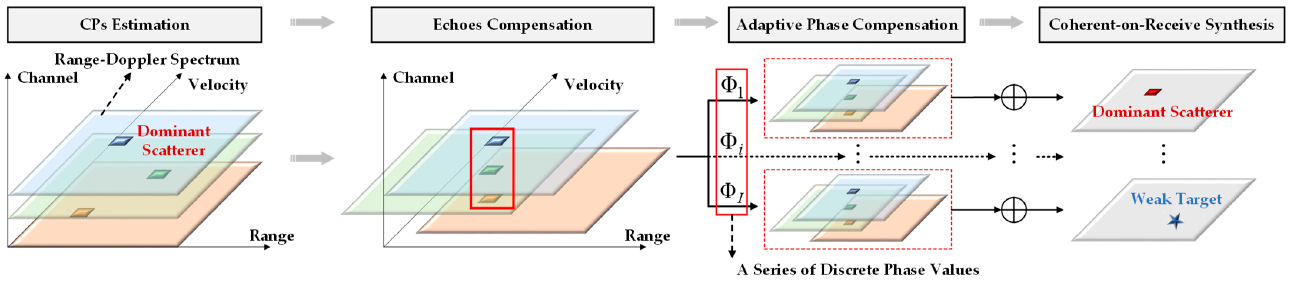
Figure 3. The processing flow of the proposed method using the dominant scatterer.